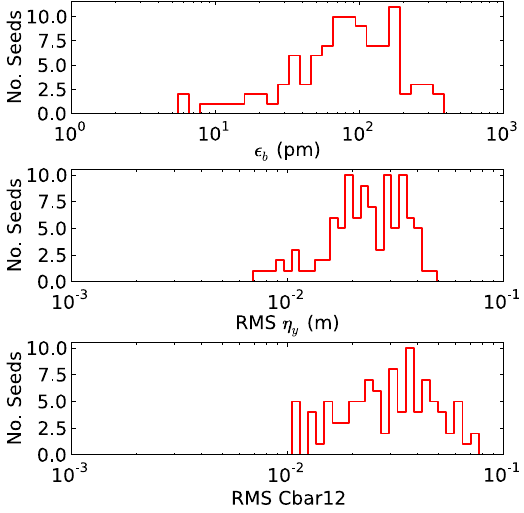
FIG. 2. Resulting distributions of vertical emittance, vertical dispersion, and coupling when applying random distributions of errors at the amplitudes specified in Table VIII, along with systematic and random multipoles specified in Table